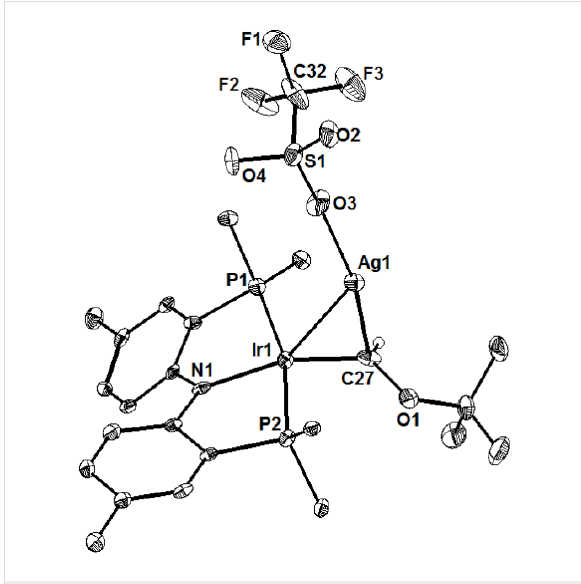
Figure 3: Single-crystal X-ray structure of a silver(I) triflate adduct of (PNP)Ir ═ C(H)O t -Bu with most H atoms and phosphine substituents (except ipso carbon atoms) omitted for